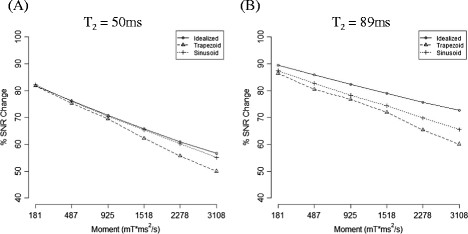
Percentage SNR decrease using iMSDE relative to the standard sequence without blood suppression (in gel phantoms). Comparison of SNR change is plotted against the idealized case (computing theoretical signal intensity change as a function of the increased effective echo time (TEeff)). Experimental observations of signal intensity change using trapezoidal and sinusoidal gradients for motion sensitization are illustrated using two calibrated gel phantoms with T2 values of 50 ms (A) and 89 ms (B) [1.5 T @ 21°C] to represent typical carotid vessel wall and muscle tissue respectively. A composite 180° pulse was used for all iMSDE preparations.